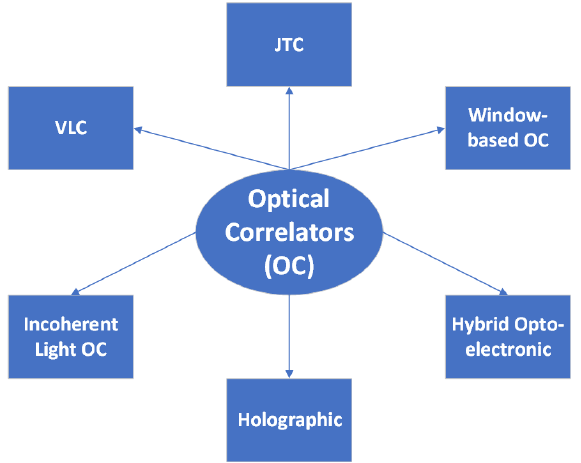
Figure 1. Optical correlator